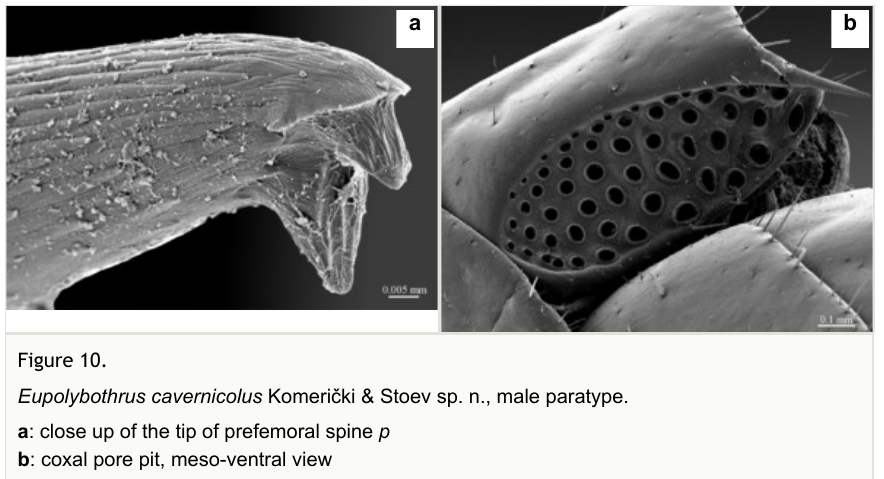
Figure 10. Eupolybothrus cavernicolus Komerički & Stoev sp. n., male paratype.